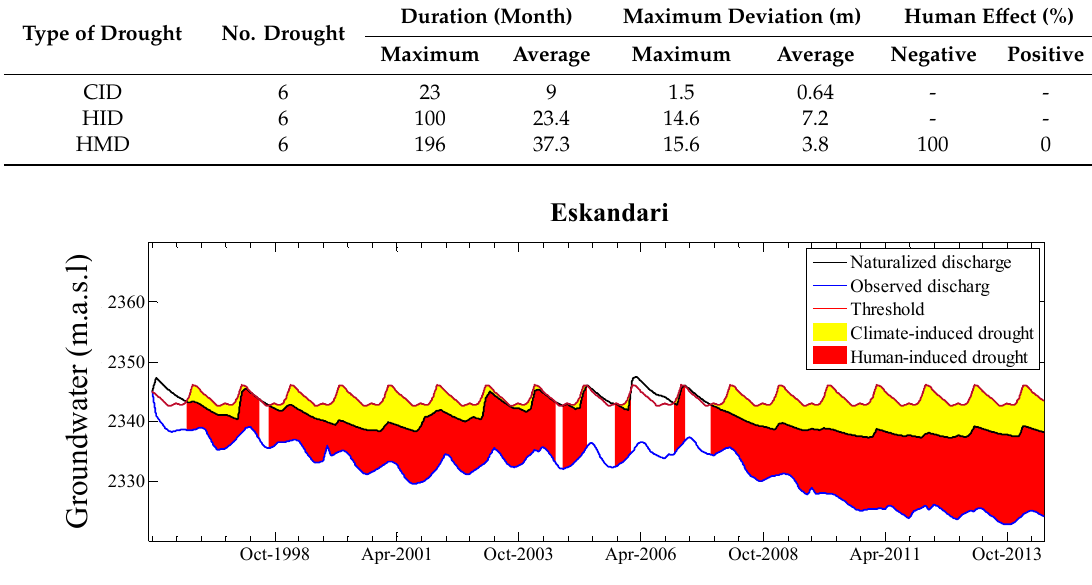
Figure 11. Groundwater drought types in the Anthropocene for Eskandari.